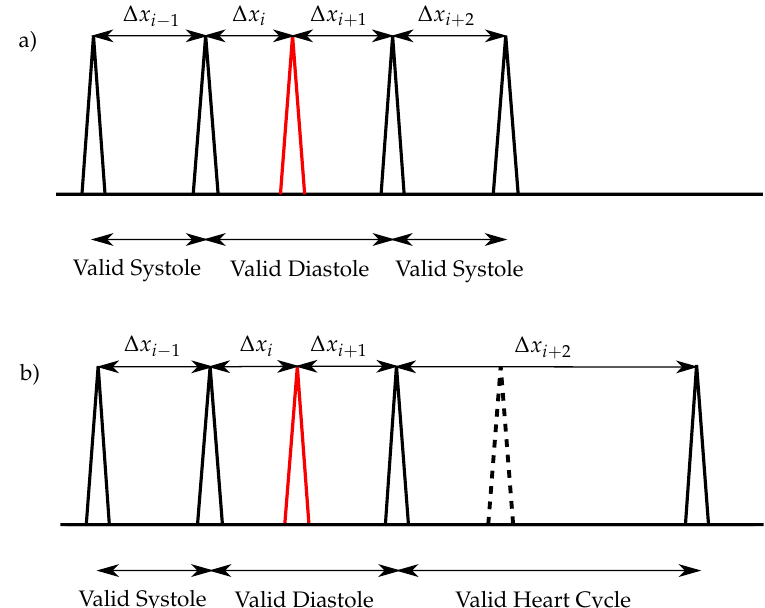
Figure 7. Heart sound classification for normal heart rates: ( a ) One extra sound (red) exists within the diastole and no S 2 is missing; ( b ) One extra sound (red) exists within the diastole and one S 2 is missing (dashed